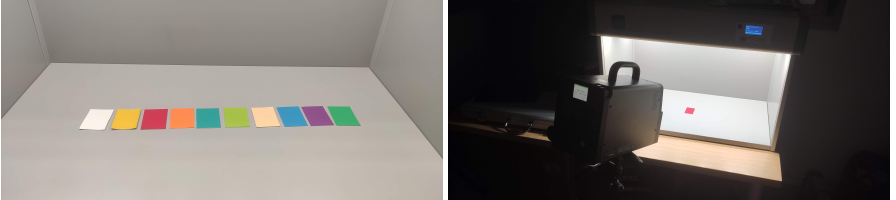
Figure 9. NCS samples used to check results ( left ) and the chromaticity measurement procedure ( right